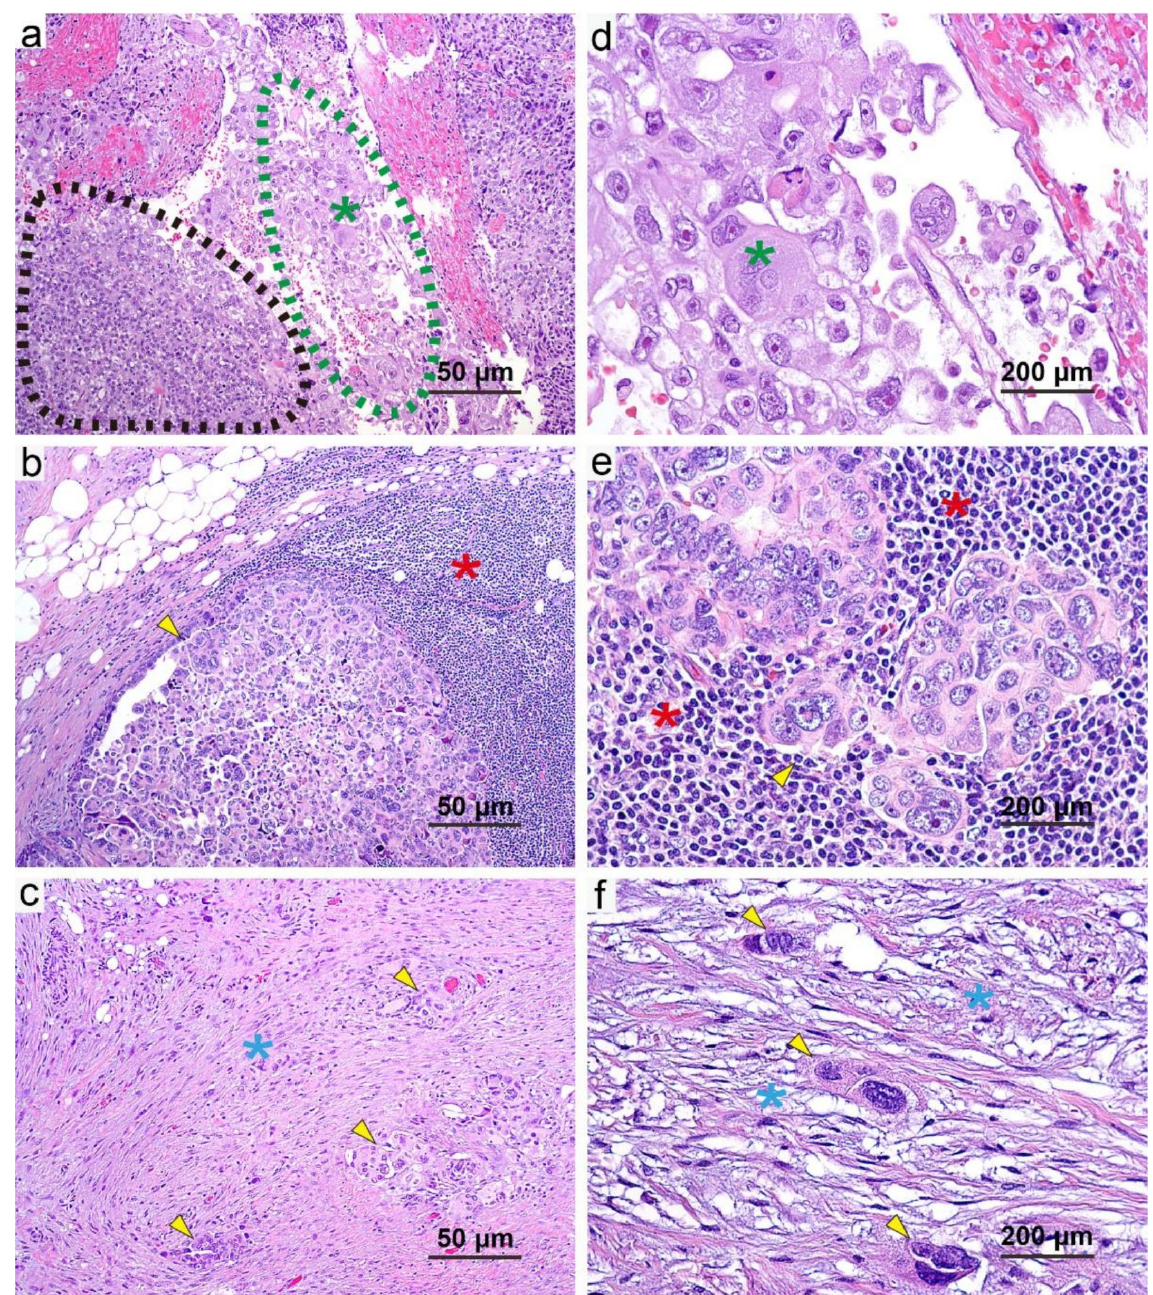
Figure 3. Representative examples of the histologic features that predicted survival in our cohort (H&E staining; scale bars: ( a – c ) 50 µ m, ( d – f ) 200 µ m). ( a , d ) Oncocytic changes (green, dotted line area with green asterisks): the abundant eosinophilic cytoplasm gives those tumor cells a pink appearance in contrast to adjacent other tumor cells (black, dotted line area). ( b , e ) Inflammation (red asterisks): inflammatory cells infiltrate around the tumor nest. ( c , f ) Desmoplasia (blue asterisks): proliferative fibroblasts with myxoid stroma are located at the periphery of the tumor foci. The yellow arrows show tumor